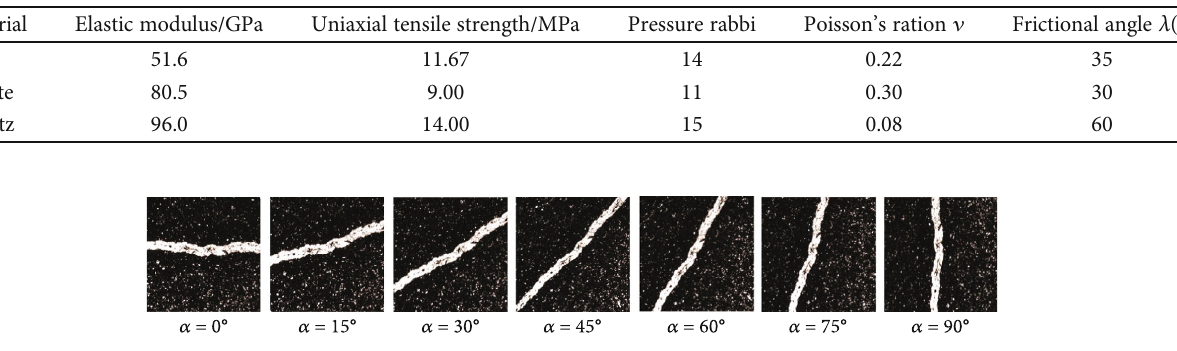
Figure 9: Digital shale images at di ff erent